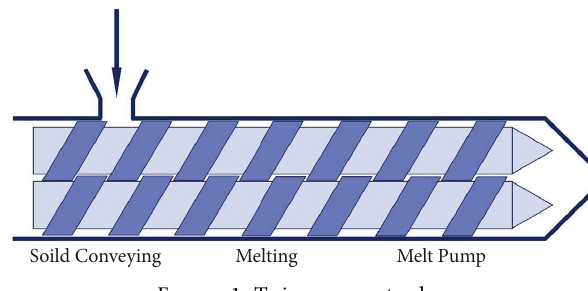
Figure 1: Twin screw